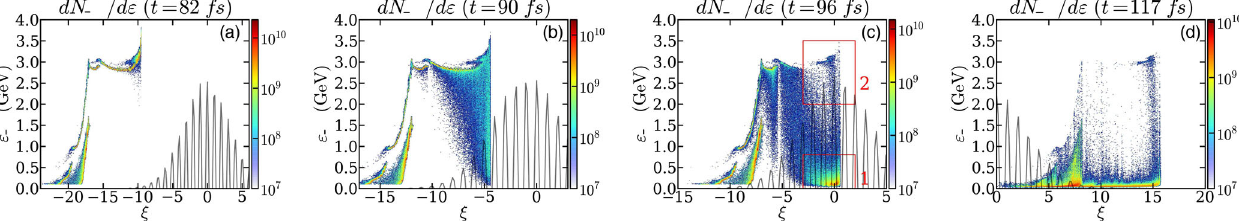
FIG. 5. Electron energy spectra (transversely integrated, in particles per GeV) before ( t ¼ 82 fs) (a), during ( t ¼ 90 fs and t ¼ 96 fs) (b,c) and after ( t ¼ 117 fs) (d) the laser-beam collision, as a function of the relative distance ξ ¼ ½ x − x p ð t Þ(cid:4) = λ 0 to the laser maximum x p ( λ 0 being the laser wavelength). In panel (c), the red frame 1 locates the on-axis beam head after strong radiative deceleration in the rising part of the laser, while the red frame 2 encloses weakly-interacting beam electrons, traveling sideways from the laser focal spot. In panels (a-d), the gray line plots (in arbitrary units) the on-axis laser field E y